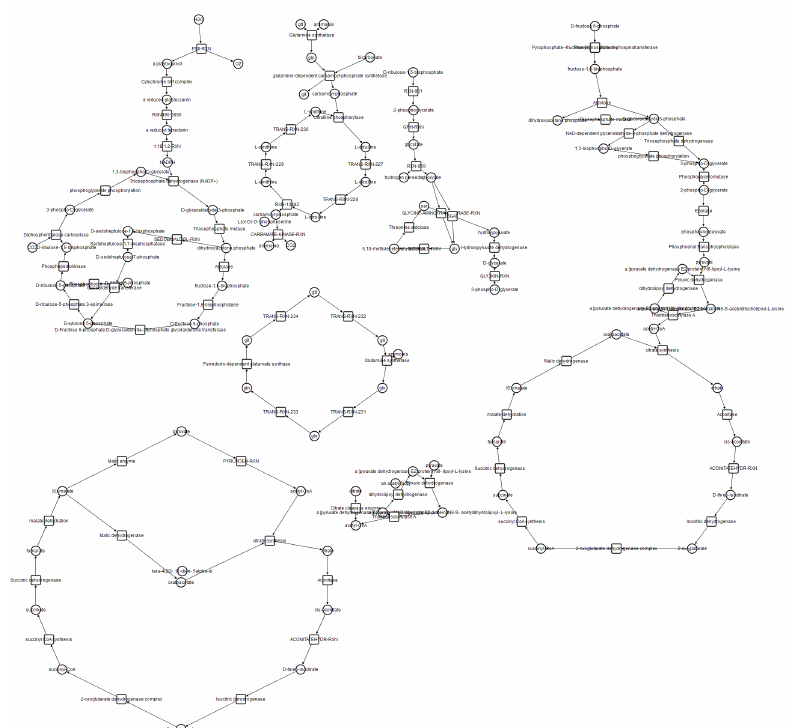
Figure 3: An example visualization of the AraCyc data. Note that although incomplete layout information is given the visualizer of the visualization tier computes complete layouts of the net-